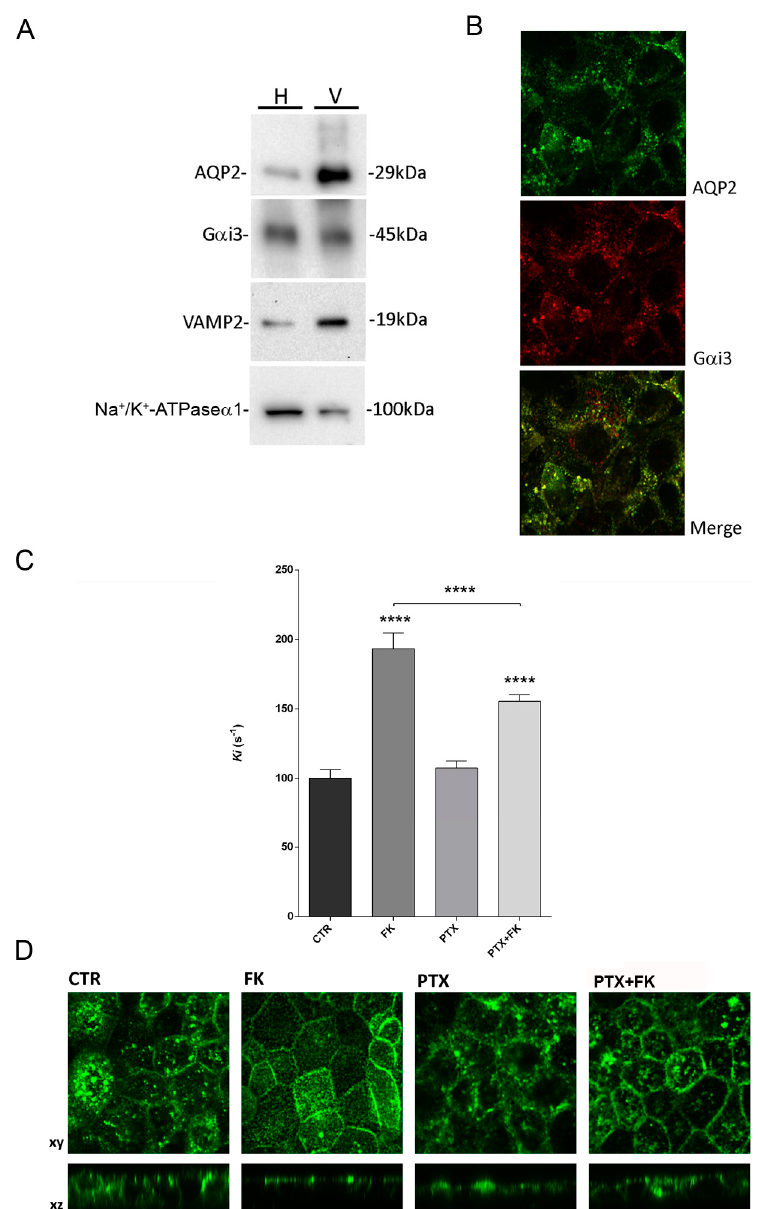
Figure 1. Inhibition of the G α i3 protein, localized in AQP2 vesicles, prevents the Forskolin-induced increase in water permeability. ( A ) Expression of AQP2, G α i3, Vamp2 and Na + /K + -ATPase in MCD4 cell homogenate and in AQP2 vesicles purified from MCD4. 30 µ g of protein from total homogenate (H) or AQP2 vesicles (V) were blotted and probed with indicated antibodies. AQP2 is found highly enriched in the vesicle fraction along with the vesicle marker VAMP2, with low contamination by plasma membranes tested using the marker Na + /K + -ATPase α 1. G α i3 appears to be expressed both in total homogenate and in vesicles fraction. Western blot is representative of 3 experiments. ( B ) Immunofluorescence localization of AQP2 and G α i3 in polarized MCD4 cells. Representative confocal images showing substantial colocalization between AQP2 (green) and G α i3 (red) evident upon overlay of individual fluorescence channels. ( C ) Effect of PTX treatment on osmotic water permeability under FK action in MCD4 cells. Cell monolayers were treated with Forskolin (100 µ M) and/or PTX (2 µ g/mL) as described in Experimental Procedures. The time course of fluorescence changes in calcein-loaded cells indicates that in cells treated with FK (100 µ M) a significant increase in osmotic water permeability reported as Ki (193.3 ± 11.22 s − 1 , **** p < 0.0001, n = 58 cells) was observed, compared to control cells (100 ± 6.05 s − 1 , n = 35 cells). In contrast, when cells were treated